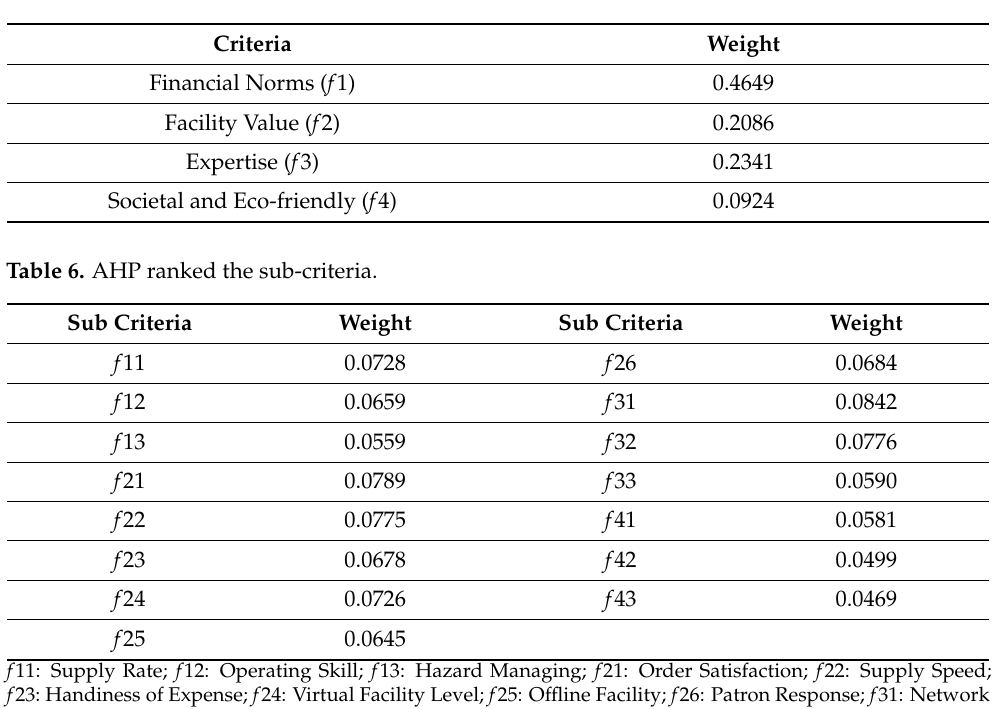
Table 5. AHP ranked the main criteria.